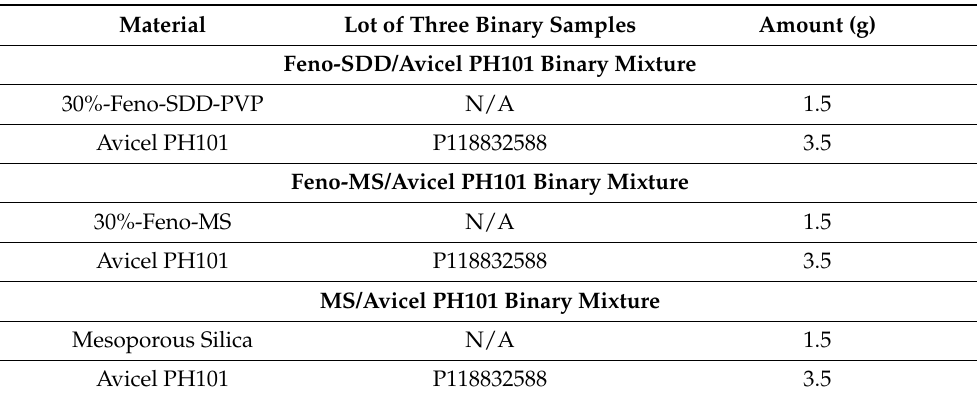
Table 1. Materials used in compression